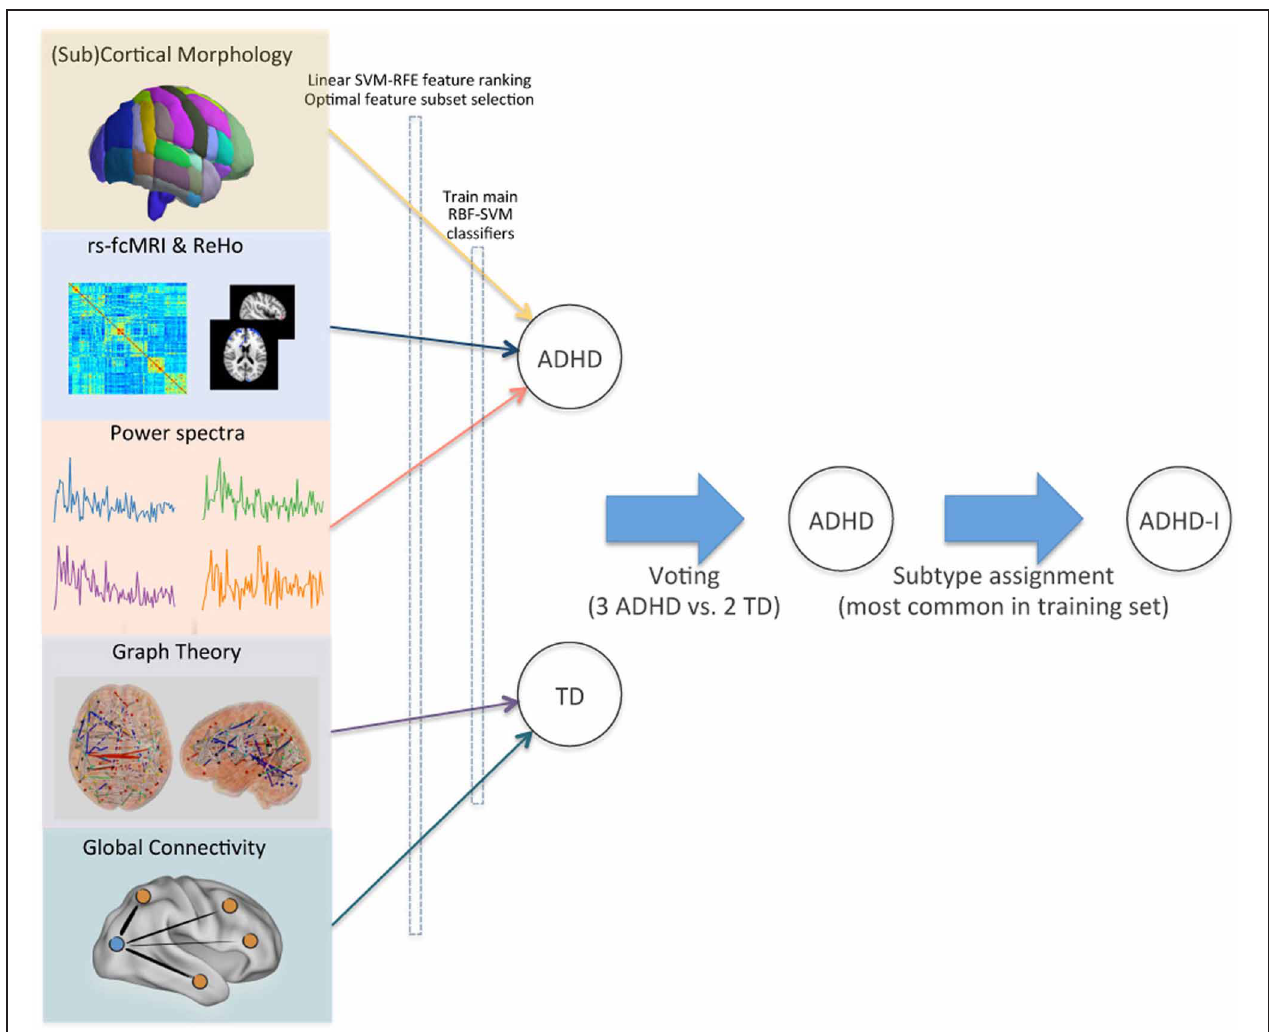
FIGURE 5 | Votingmethodforcombiningmodalities. Optimal feature subsetswerederivedforeachsiteandimagingmodality,andusedtotrainasetof RBF-SVMclassifiers. Class predictions from these modality-specific classifiers